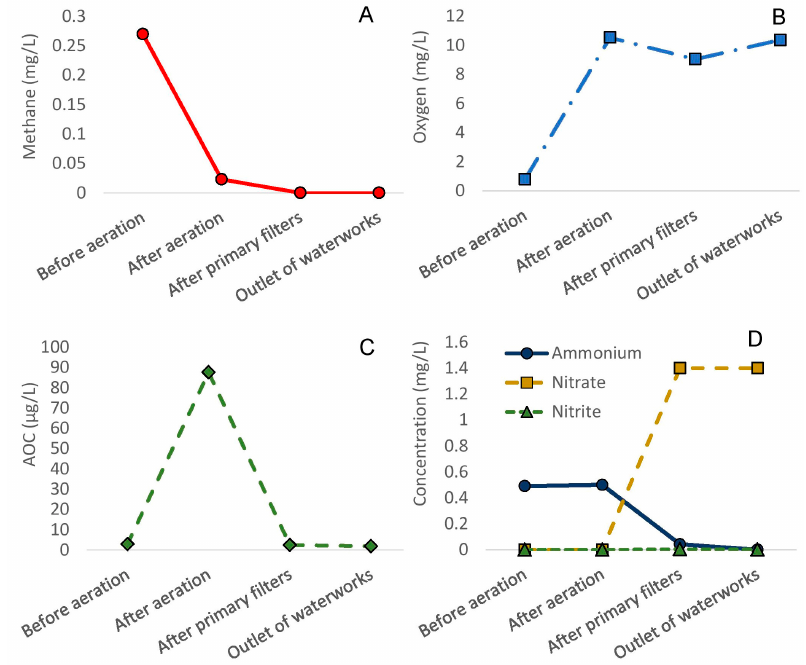
Figure 1. Water quality parameters before aeration, after aeration (reaction chamber), after primary sand filters and at the outlet of Slangerup waterworks. Concentration of ( A ) methane (mg/L), ( B ) oxygen (mg/L), ( C ) AOC (µg/L) and ( D ) ammonium, nitrite and nitrate (mg/L).